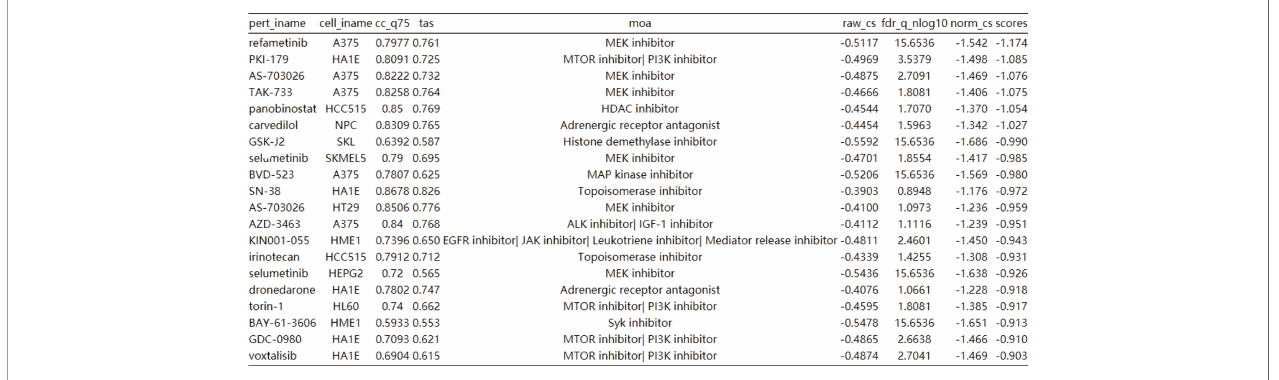
FIGURE 7 | Cmap analysis after activation of HIF-1 signaling pathway. The fi rst 20 compounds are